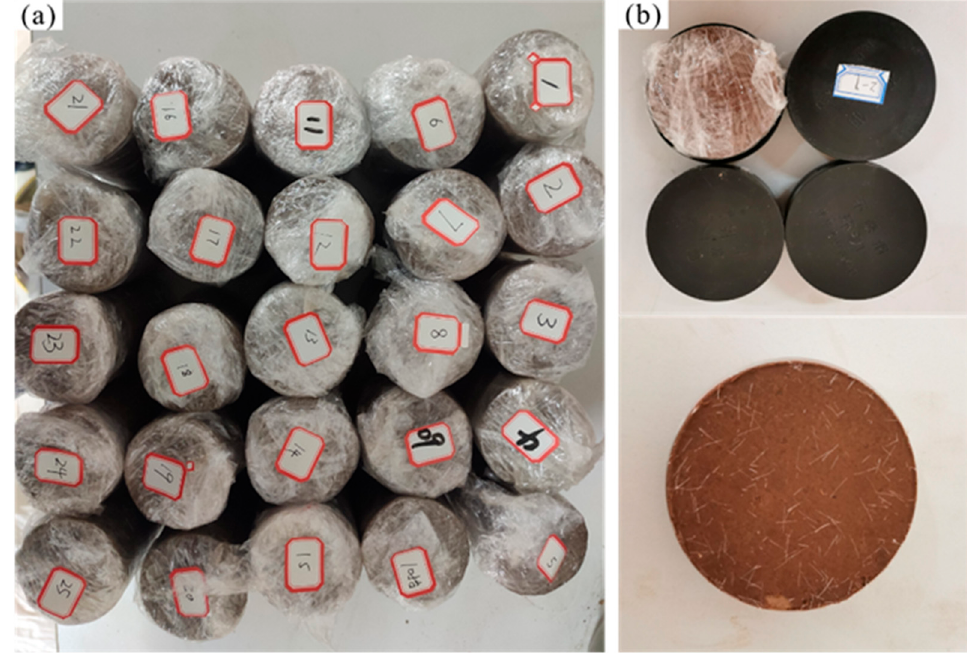
Figure 4. The improved loess samples: ( a ) cylindrical samples; ( b ) ring knife samples.